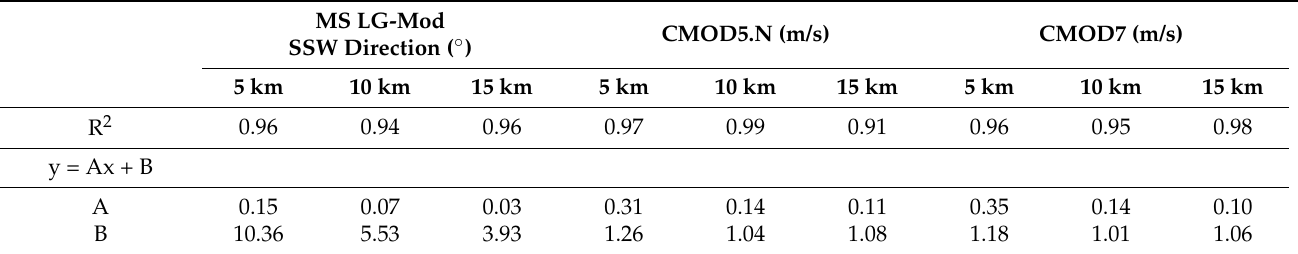
Table 5. Statistics derived from the direct comparison (scatterplot) between the SAR-derived SSW direction and speed uncertainty (i.e., ∆ ϕ and ∆ W max , respectively) and the absolute difference of the SAR-derived SSW direction and speed estimates with the corresponding ECMWF ones (i.e., | ϕ - ϕ ECMWF | and |W-W ECMWF |, respectively). Statistics obtained for all ROIs, at various dimensions. Two different GMFs applied for wind speed